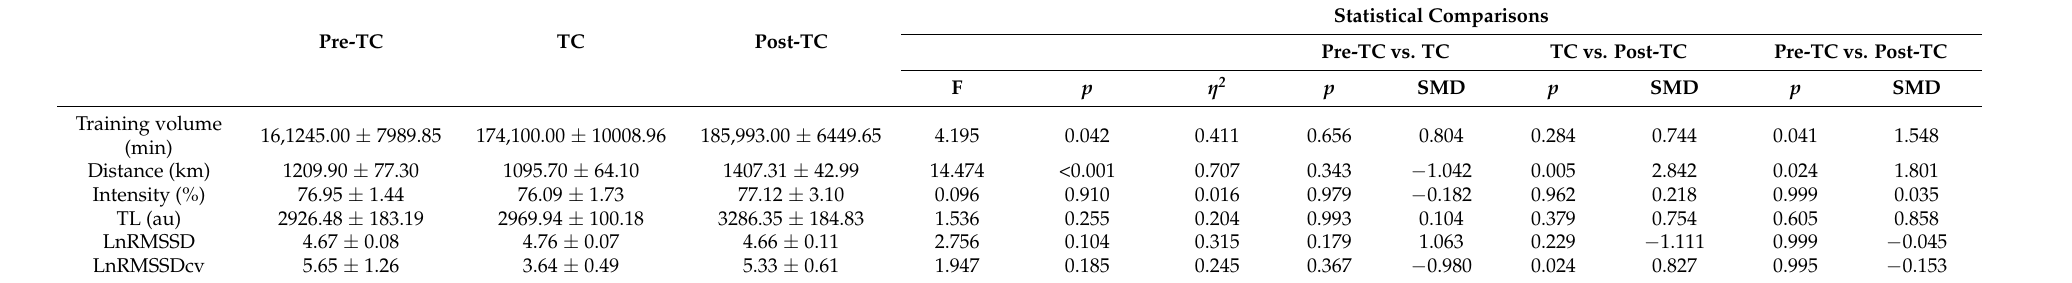
Table 1. Cardiac autonomic measures, training load values and statistical